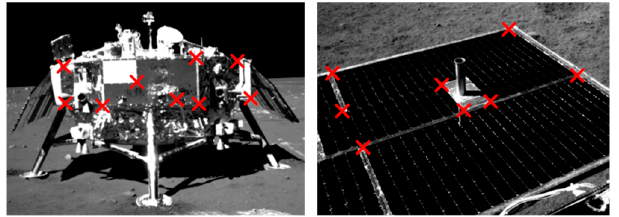
taken at station C. Figure 17 shows the distribution of virtual control points on the solar panel of the lander and planetary rover whose coordinates are measured on the ground.